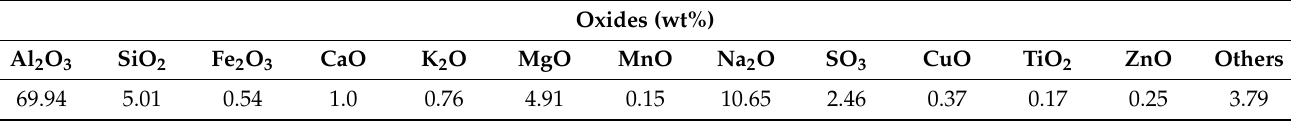
Table 1. Composition of aluminum dross.